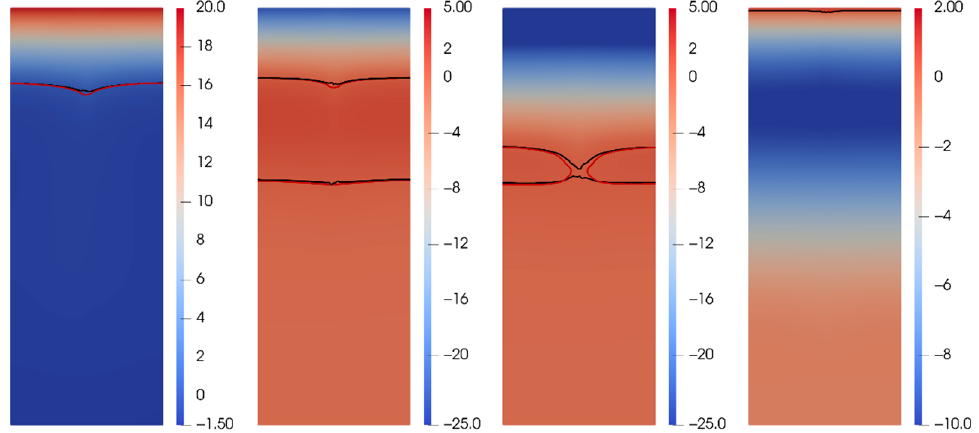
Figure 7. Temperature distribution for different time layers ( t = 50, 200, 250, 365 days) in case of basalt fiber reinforcement. From left to right. (red line is isocline of zero for structure locations, black is isocline of zero for random locations).